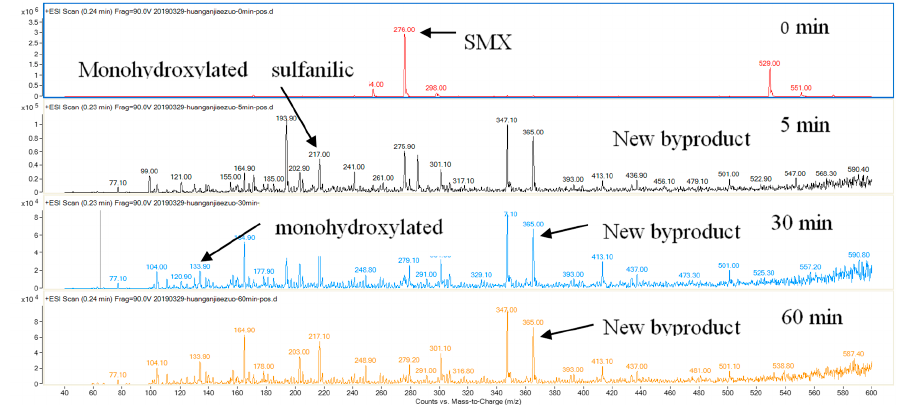
Figure 5. The RRLC-MS analysis of SMX and its degradation byproducts in the liquid samples that underwent different reaction times (0, 5, 30, and 60 min). Nanomaterials 2020 , 10 , x FOR PEER REVIEW